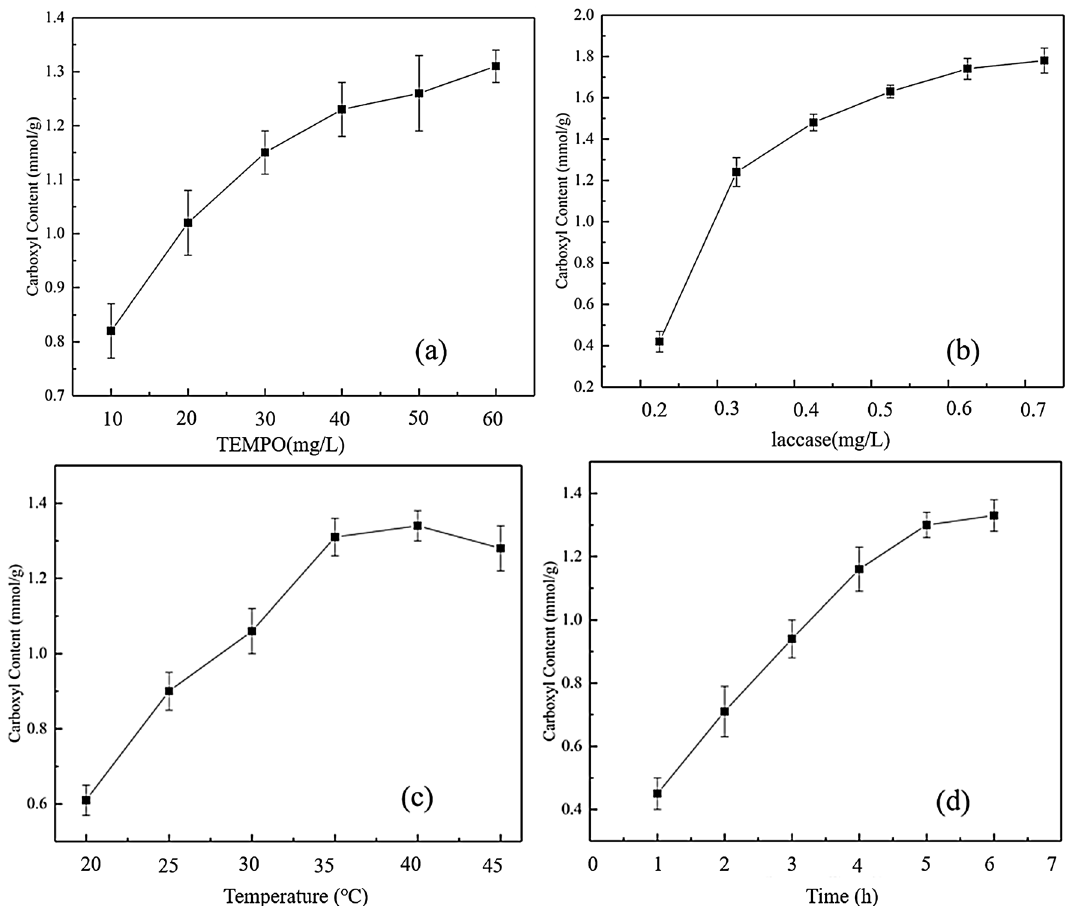
Figure 1. Effect of TEMPO factor ( a ), laccase factor ( b ), reaction temperature ( c ) and reaction time ( d ) on the carboxyl content of openSu.